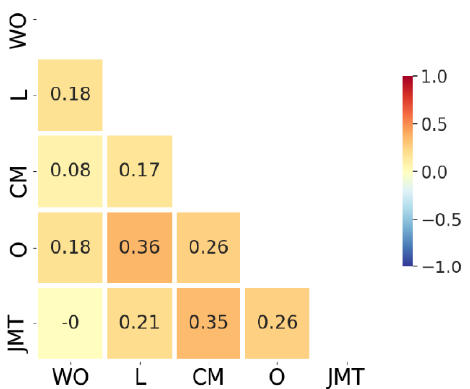
Figure 3. Correlation matrix among sales volumes of five items (WelshOnion (WO), Lettuce (L), ChineseMallow (CM), Onion (O), and JujubeMiniTomato (JMT)).